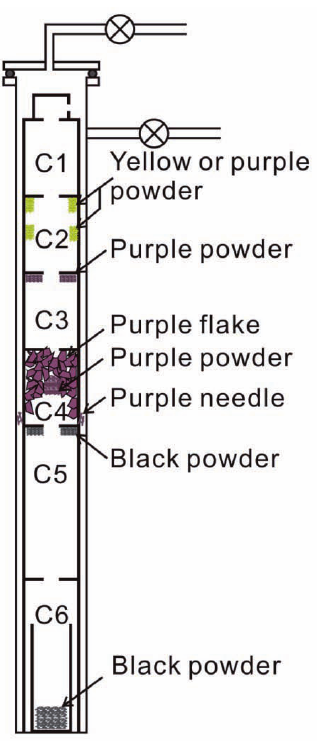
Figure 6. Schematic illustration of the distillation tube after the experiment.